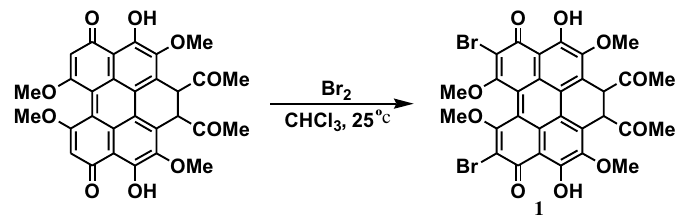
Fig. 3. Synthesis of 1